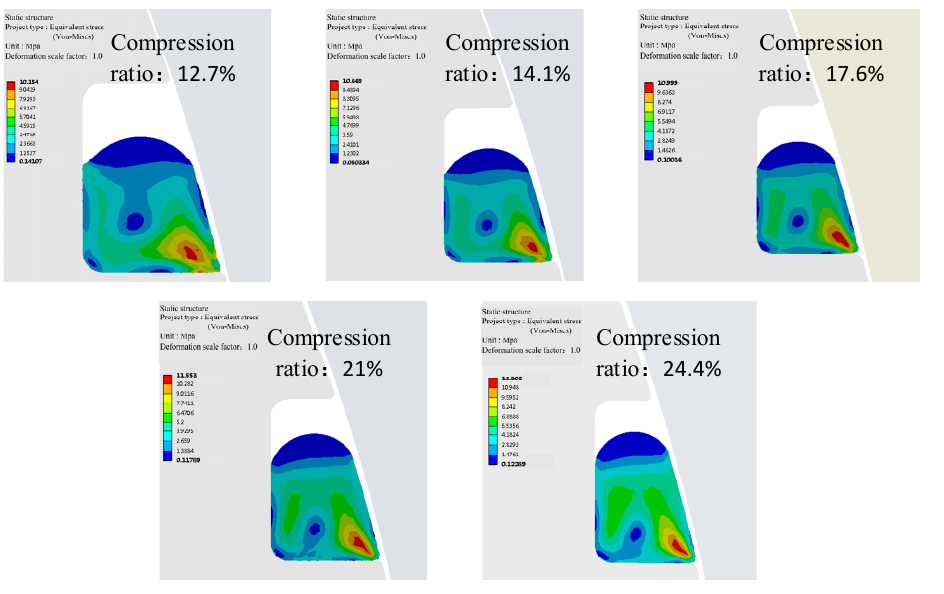
Figure 17. Diagrams of equivalent stresses under different compression ratios.